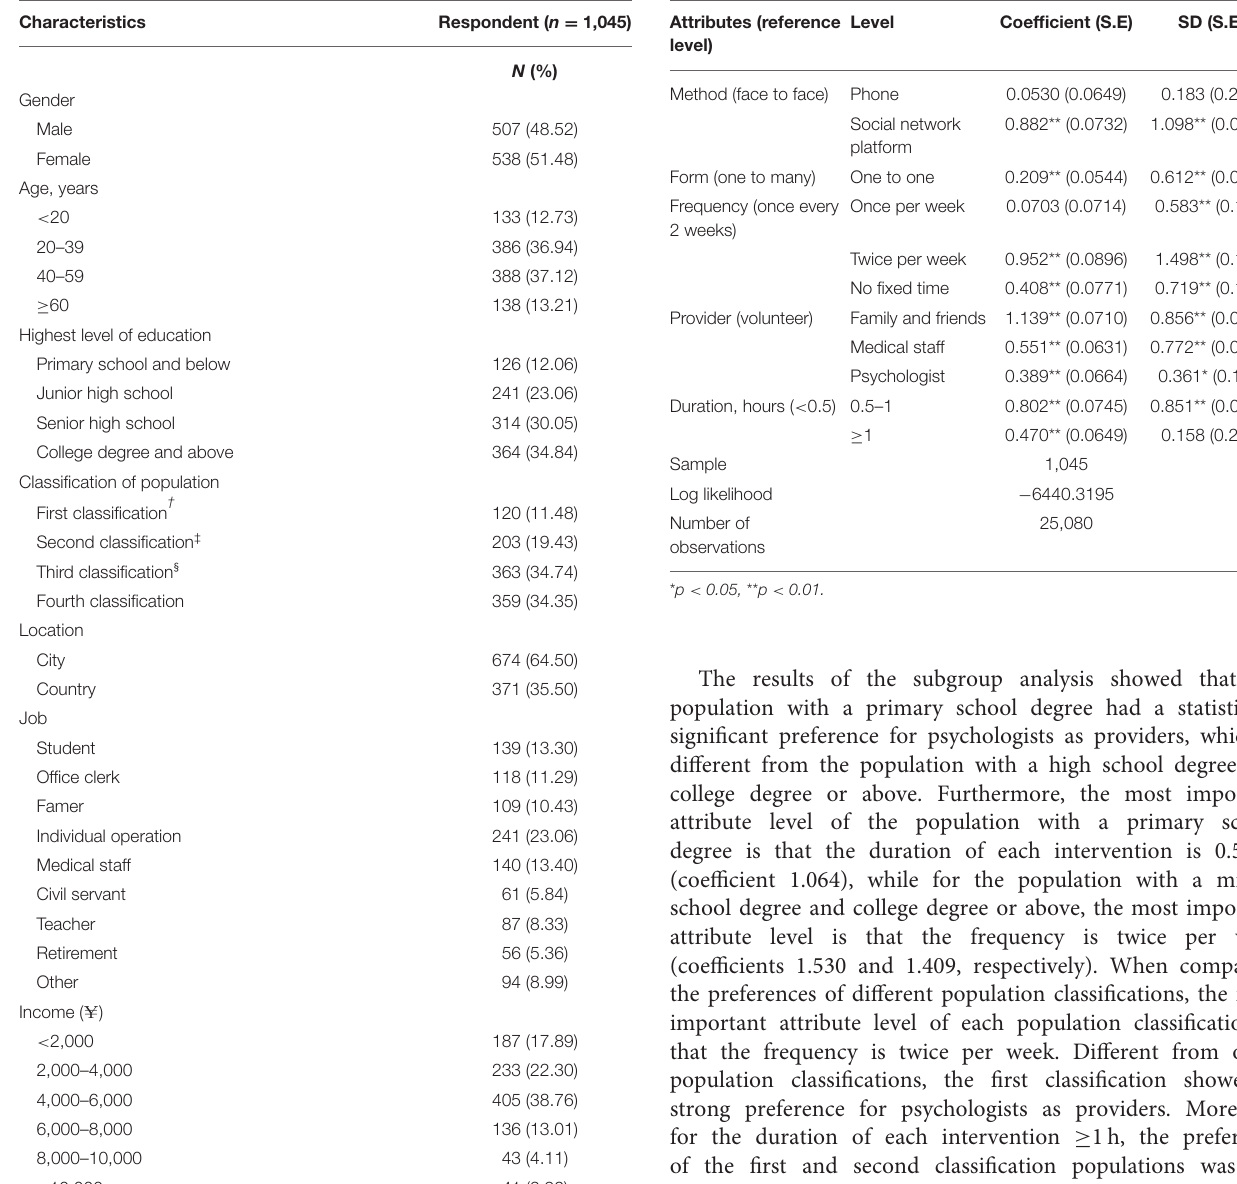
TABLE 2 | Respondent characteristics. TABLE 3 | Mixed logit estimates for total sample ( n =